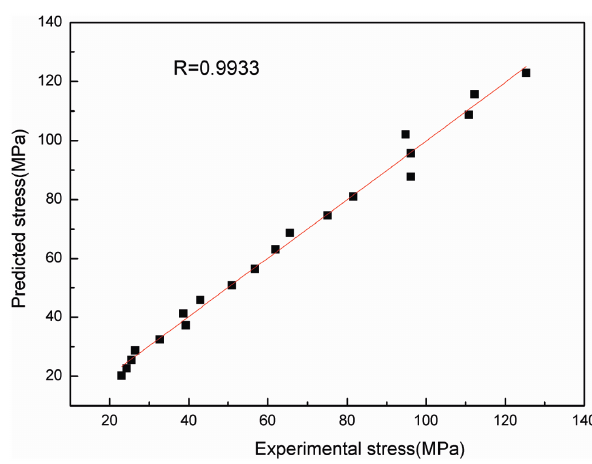
Figure 7: Comparison between predicted stress and experimental